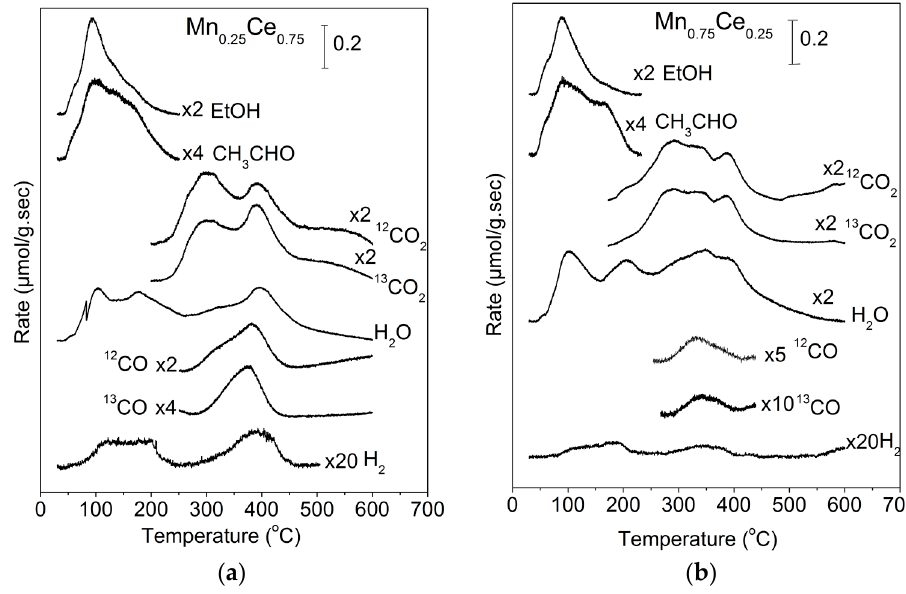
Figure 2. ( a ) TPD profiles following 12 CH 313 CH 2 OH adsorption on Mn 0.25 Ce 0.75 catalyst, ( b ) TPD profiles following 12 CH 313 CH 2 OH adsorption on Mn 0.75 Ce 0.25 catalyst.